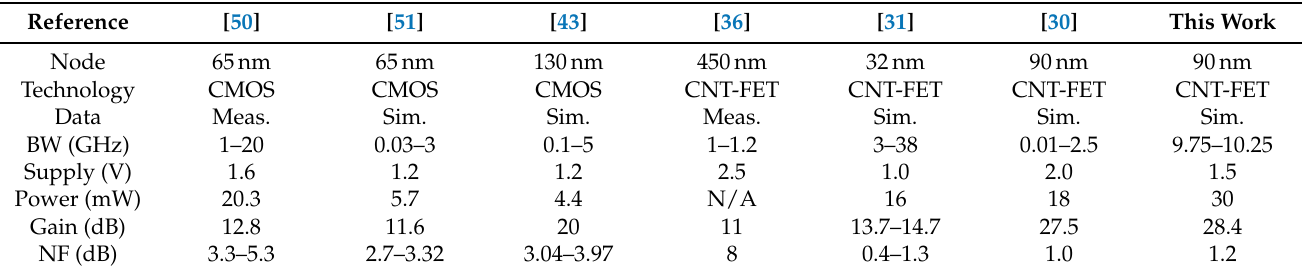
Table 2. Performance comparison of the designed LNA with other